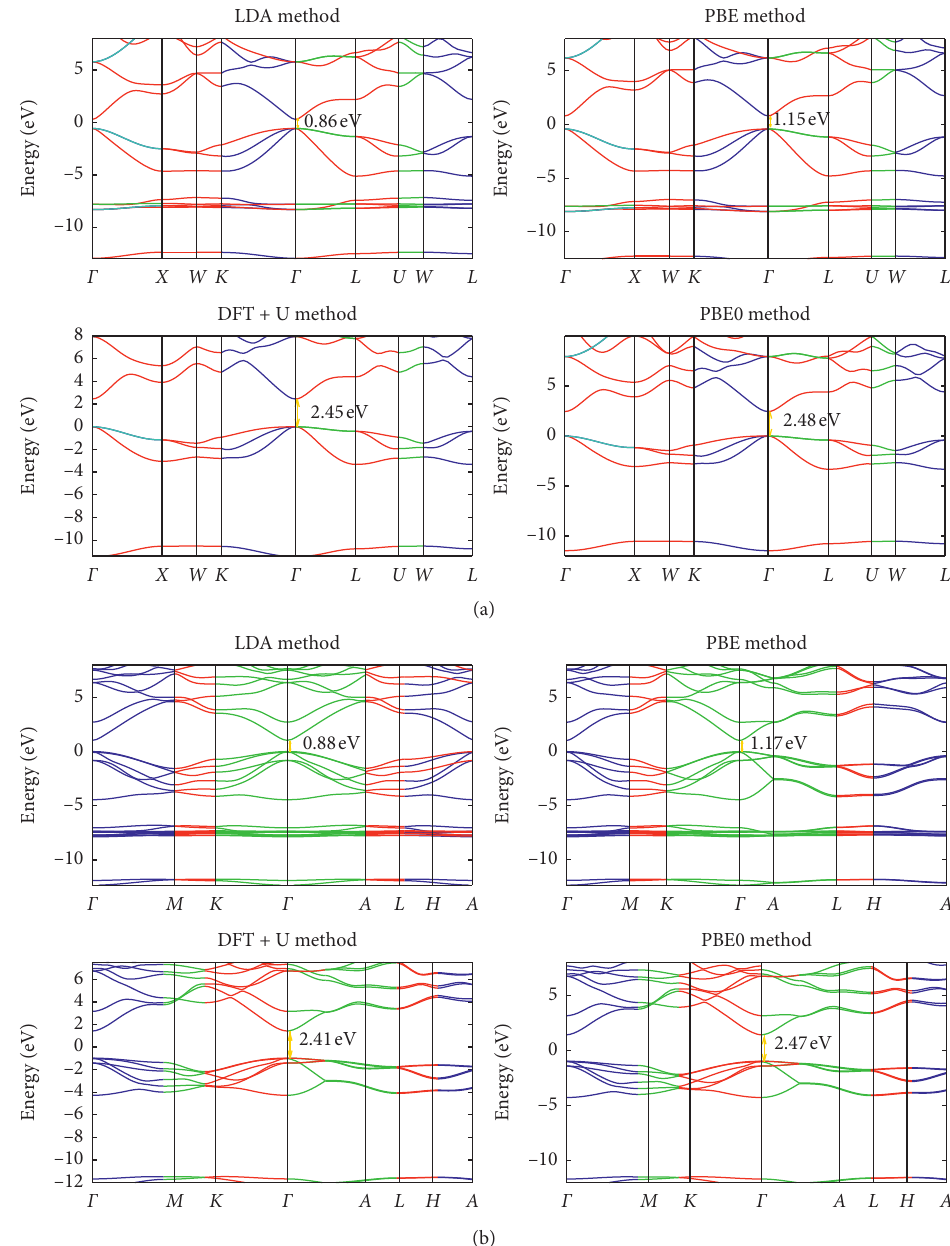
Figure 2: Band structure of (a) zb-CdS structure and (b) wz-CdS structure along high symmetry points with respect to LDA, PBE, PBE+U, and PBE0